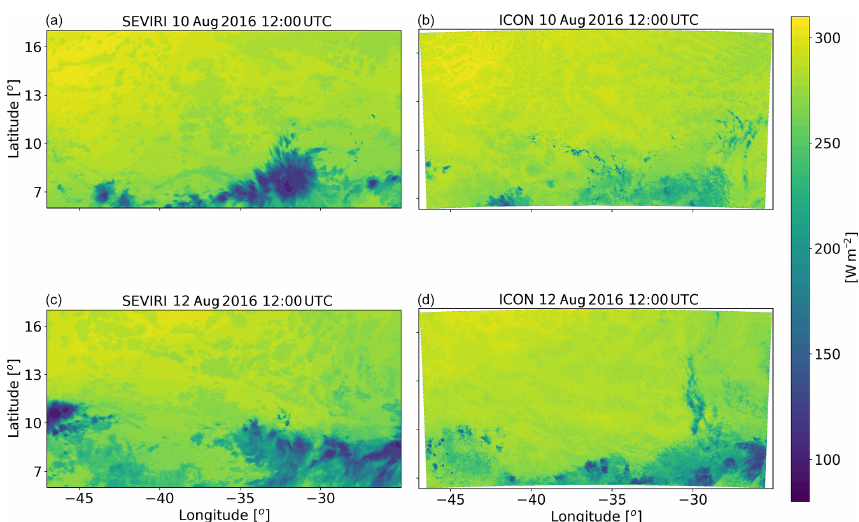
Figure 2. Outgoing longwave flux at the top of atmosphere at the initial stage (a, b) and the last stage ( c , d – each average over 30min) of the simulation of the shallow-cloud-dominated case (10–12 August 2016) from geo-stationary satellite (SEVIRI-MSG – b , d ) and the ICON model simulation with CDNC of 20cm − 3 (a, c) .